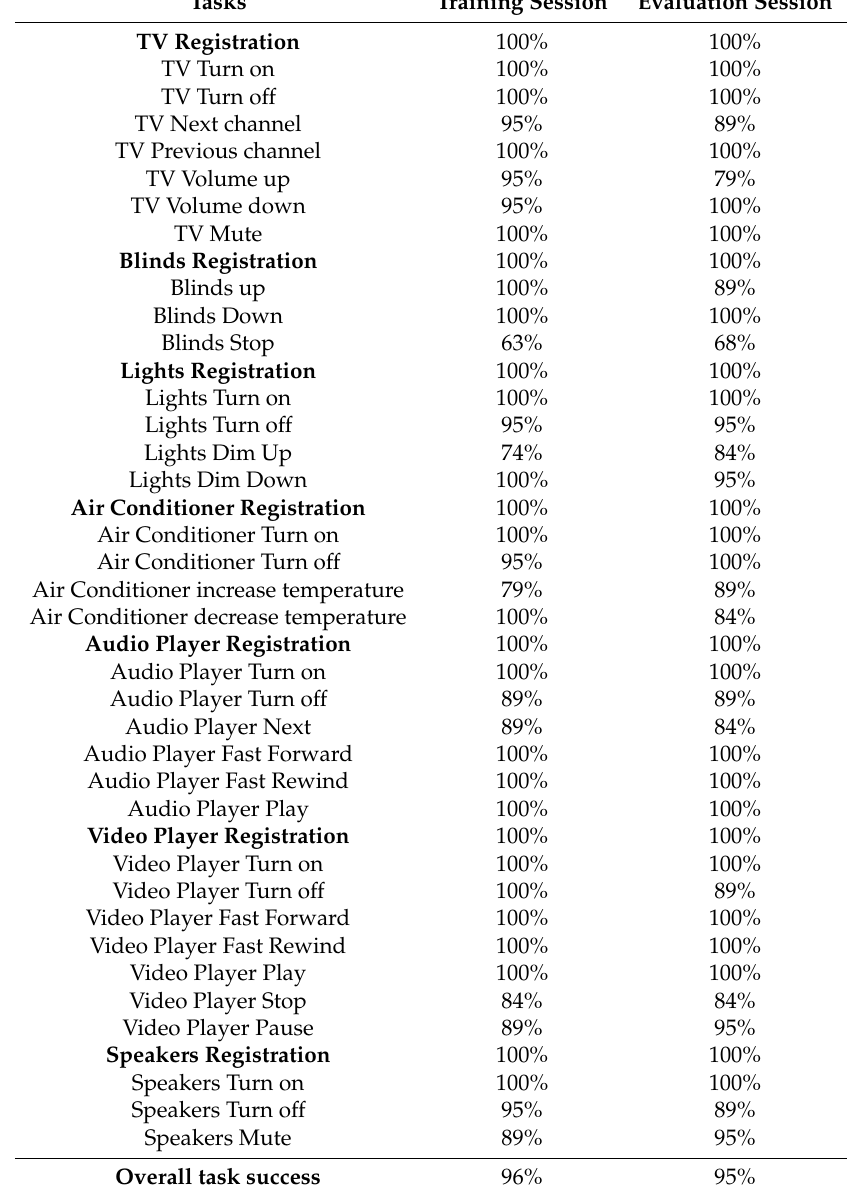
Table 3. Task success during training and evaluation